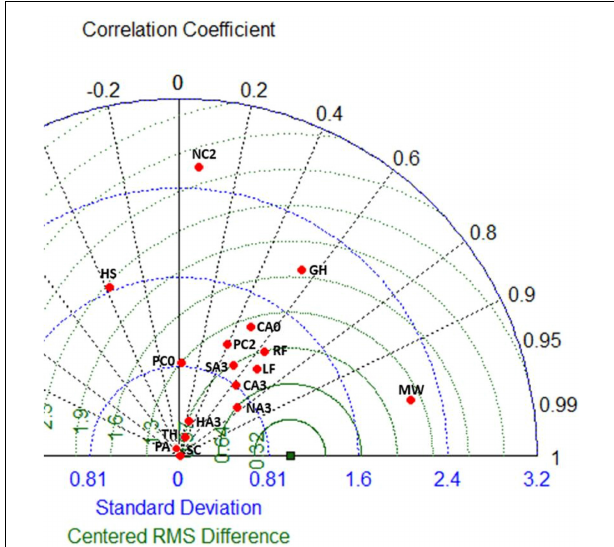
FIGURE 3 | Taylor diagram showing correlation (Pearson r), residual mean square (RMS), and ratio of the standard deviations (scaled) of model simulated (model M10) and observed time-series. Reference point where observed is equal to modeled values is shown by green square. Symbol labels; minke whales (MW), harp seals (HS), Northeast Arctic cod 3+ (NA3), coastal cod 2+ (NC2), saithe 3+ (SA3), haddock 3+ (HA3), large Greenland halibut (GH), large redfish (RFL), capelin 3+ (CA3), capelin 0–2 (CA0), Polar cod 2+ (PC2), polar cod 0–1 (PC0), lumpfish (LF), pelagic amphipods (PA), Thysanoessa (TH), and Scyphomedusae (SC). Groups with higher variability in observed than in modeled time-series, such as haddock age 3+, Thysanoessa , pelagic amphipods, and Scyphomedusae are positioned close to zero scaled deviation ratio.